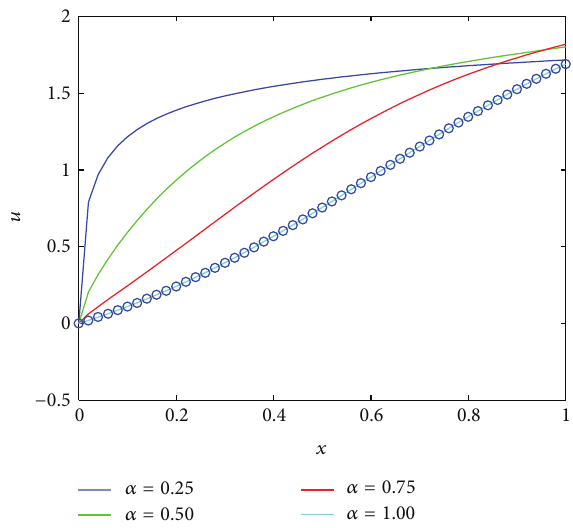
Figure 3: Numerical solutions for Example